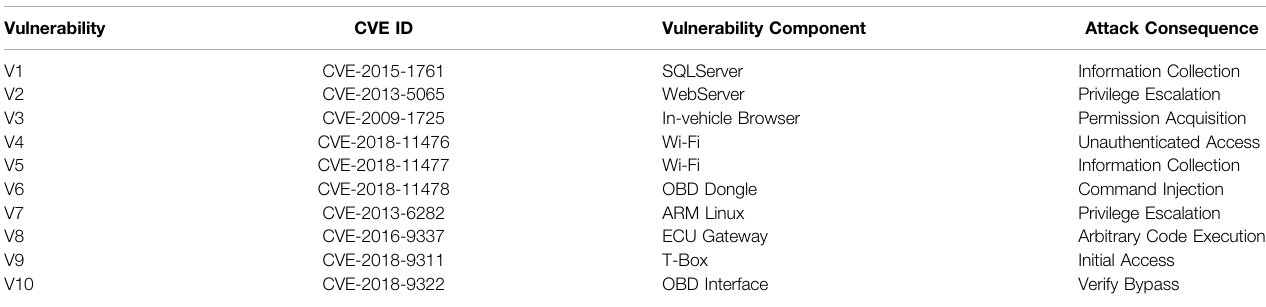
TABLE 1 | Vulnerability